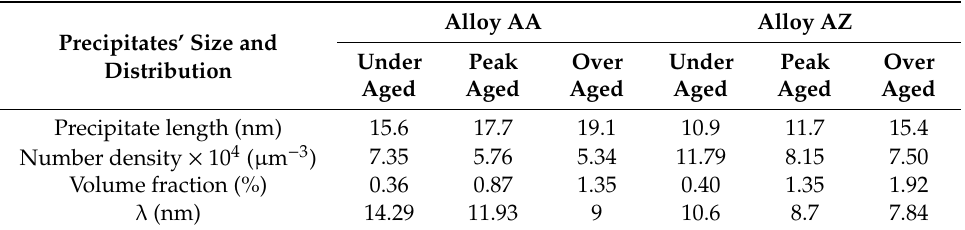
Table 3. Quantitative TEM studies of precipitates in the alloys AA and